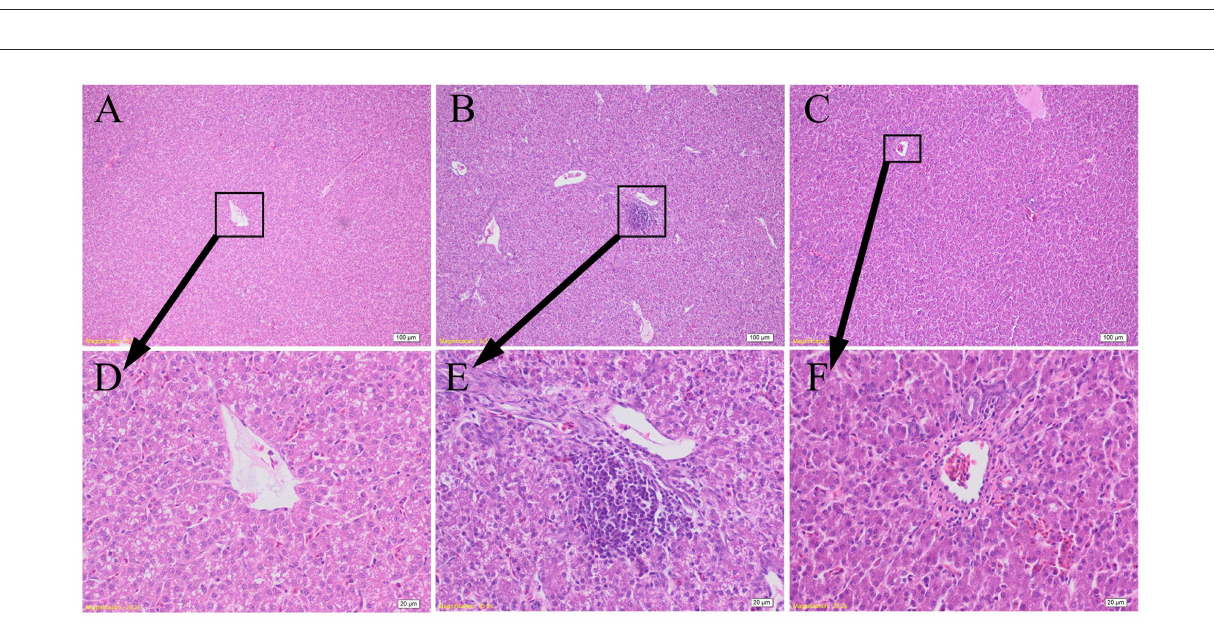
showed no statistically significant difference compared with the CON broilers ( p >